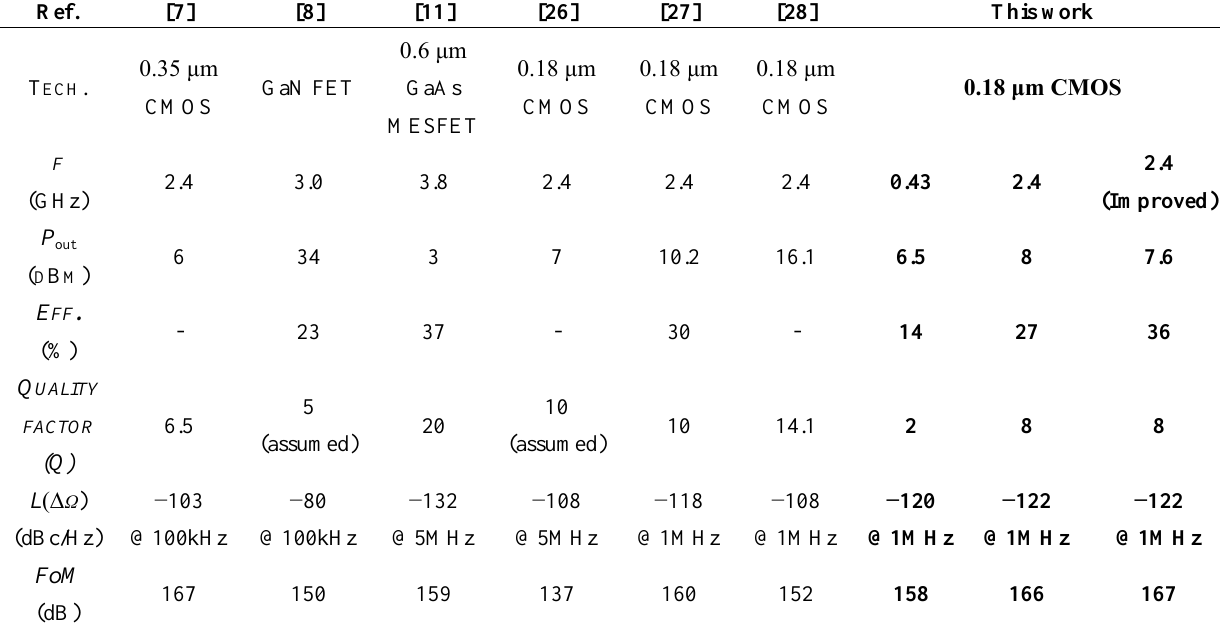
Table 1. Performance comparison with previously published VCO transmitters.